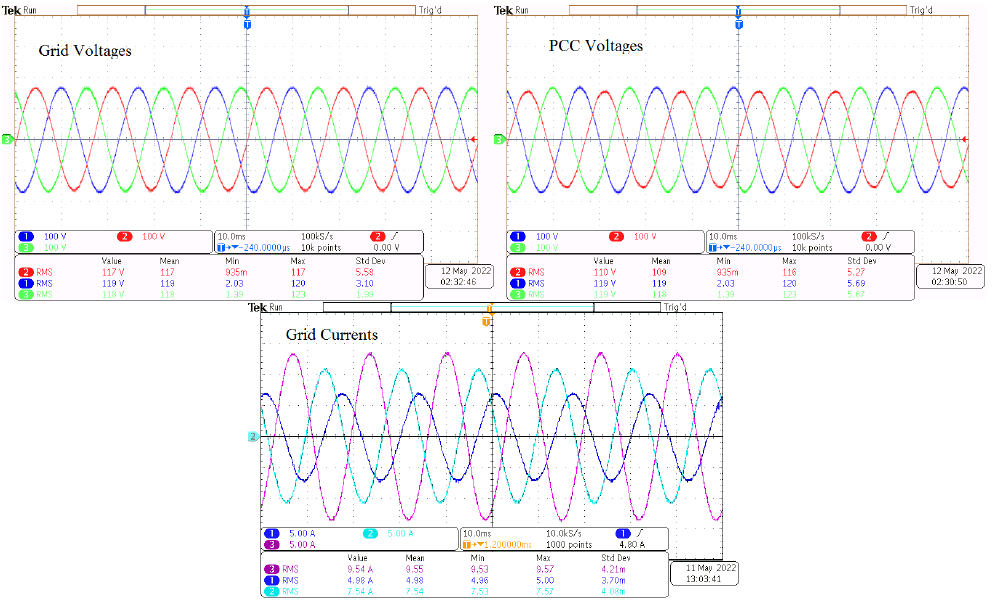
Figure 10. Experimental results before energizing the